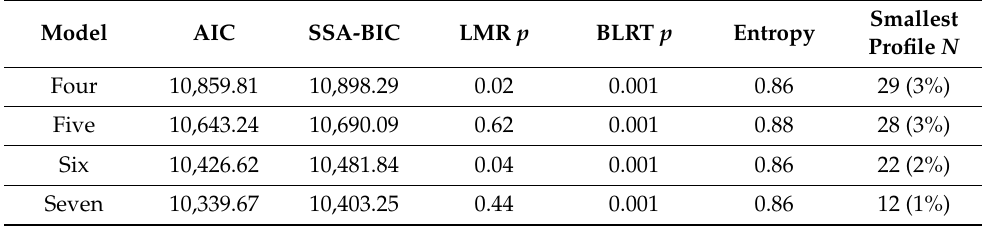
Table 3. Cross-sectional Latent Profile